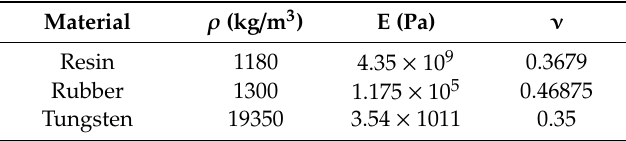
Figure 2. Phononic crystals cavity plates cell. Table 1. Material